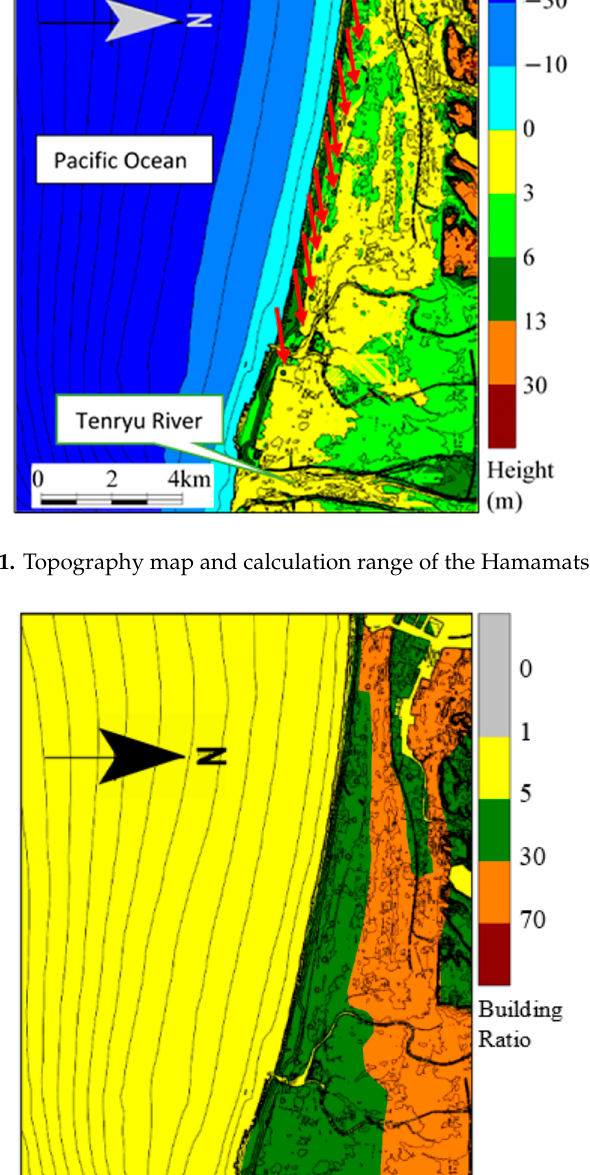
Figure 13. Inundation depths 33 min after the start of calculation (present condition).